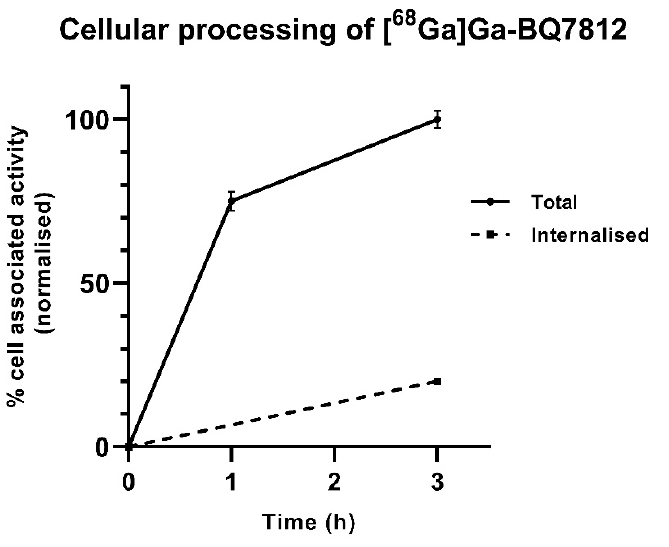
Figure 3. Cellular processing of [ 68 Ga]Ga-BQ7812. Values are normalized to the highest uptake in the experiment.